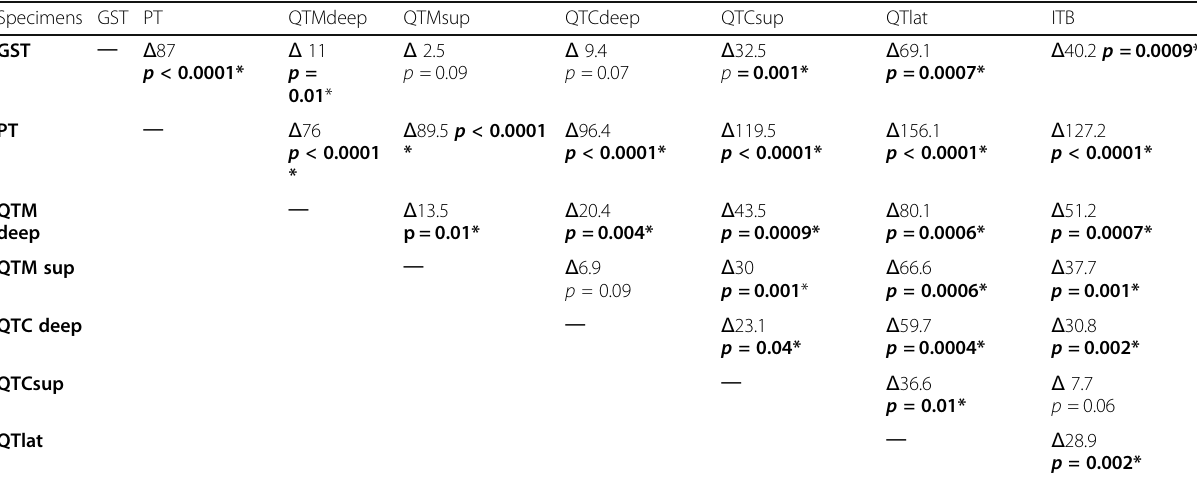
Table 3 Comparison between specimens in terms of Elastic Moduli (Mean values) Specimens GST PT QTMdeep QTMsup